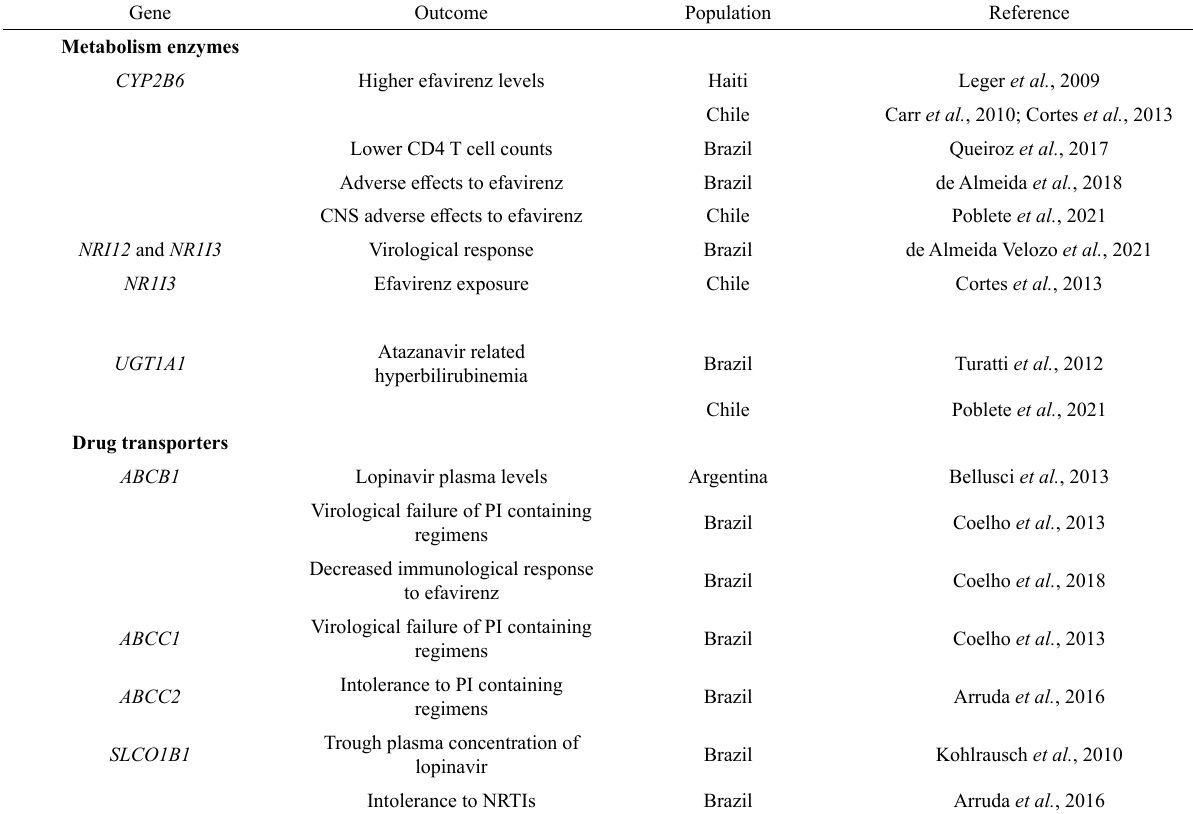
Table 1. Associations between ADME genes and response to antiretroviral therapy in Latin American populations.